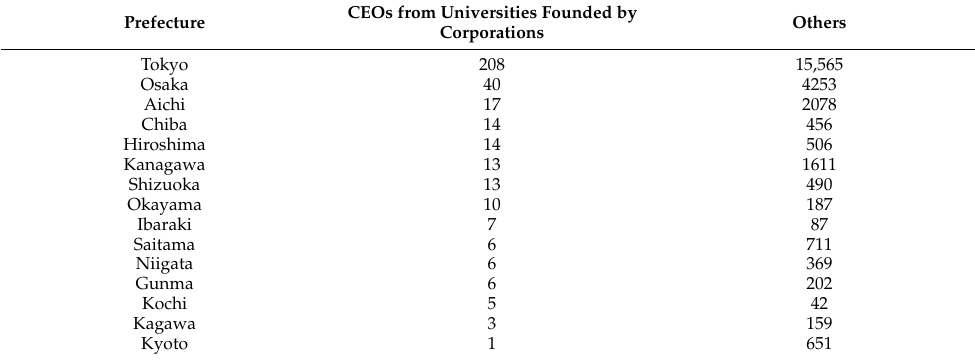
Table A4. Prefecture Distribution of headquarters.